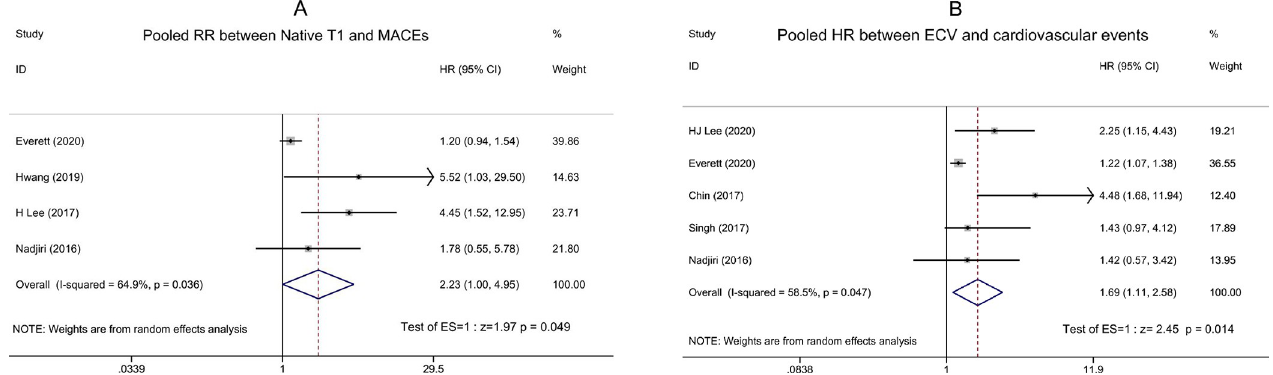
Fig 3. Forest plots showing the pooled RR or HR between Native T1 or ECV and cardiovascular events in patient with AS. (A) The pooled HR between Native T1 and MACEs; (B) The pooled HR between ECV and cardiovascular events. � RR relative risk, HR hazard ratio, MACEs major adverse cardiovascular events, ECV extracellular